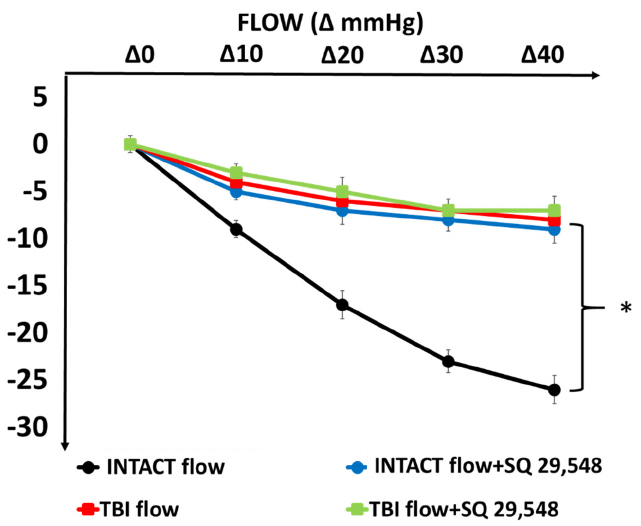
Figure 1. Changes in diameter of isolated middle cerebral arteries (MCAs) in response to step increases in intraluminal, flow ( ∆ 0, ∆ 10, ∆ 20, ∆ 30, ∆ 40 mmHg between inflow and outflow cannulas) from intact rats and from rats after traumatic brain injury (TBI) in the absence and presence of SQ 29,548 (10 − 6 mol/L) an inhibitor of thromboxane A 2 receptor (TP). Asterisks indicate significant differences * p < 0.05 vs. Intact flow and Intact flow with SQ 29,548 ( n = 16, n = 8 in each group). Similarly, in the presence of SQ 29,548 (10 − 6 mol/L), an inhibitor of thromboxane- prostanoid receptor (TP receptors) flow-induced constrictions of MCA from intact rats were significantly reduced and after TBI, the reduced constrictor responses were not fur- ther affected by SQ 29,548.